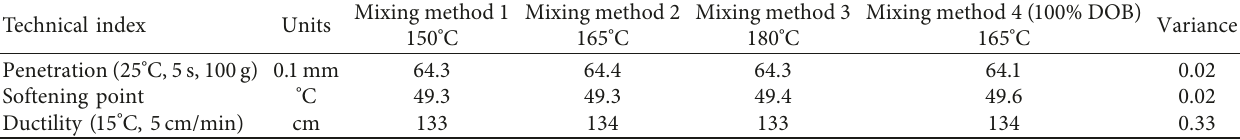
Table 9: Test results of the extracted HMRAM binder for the four mixing methods.